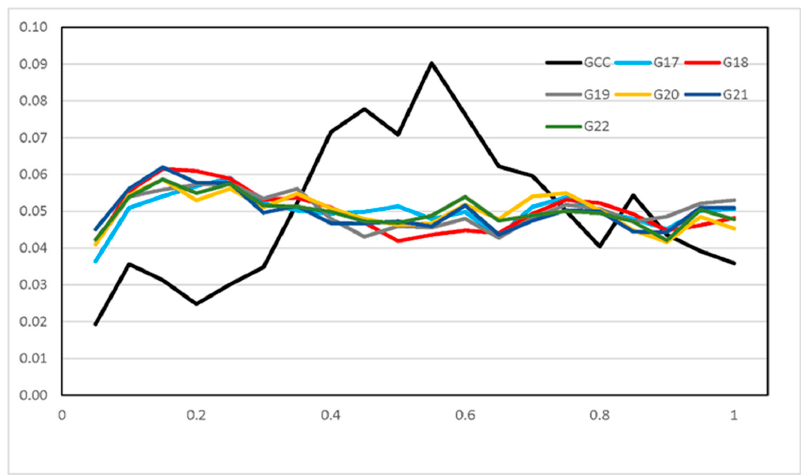
Figure 7. Distribution of ROHs for inbred and non-inbred WZSPs along a chromosome. The relative chromosomal position on a chromosome was calculated by standardizing the original physical position by the chromosome length: a value of zero corresponds to the beginning of a chromosome and a value of one corresponds to the end. The distributions are averaged across all chromosomes. Non-inbred pigs are shown in black, and six generations in inbred pigs are indicated by various colors. x-axis: the relative chromosomal position on a chromosome; y-axis: relative frequency of ROHs.